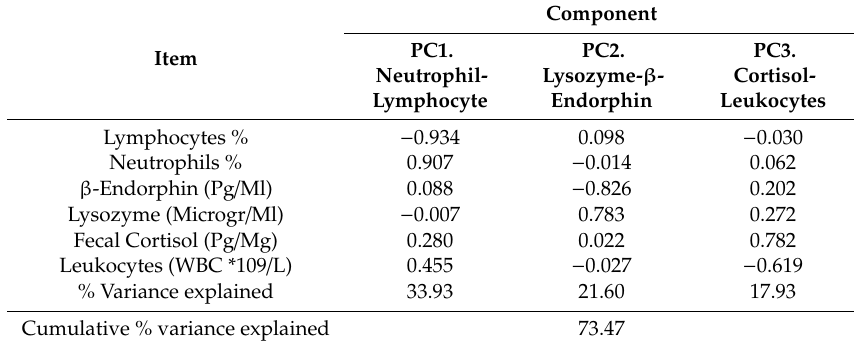
Table 1. Factor loadings for the laboratory parameters included in the principal component analysis.